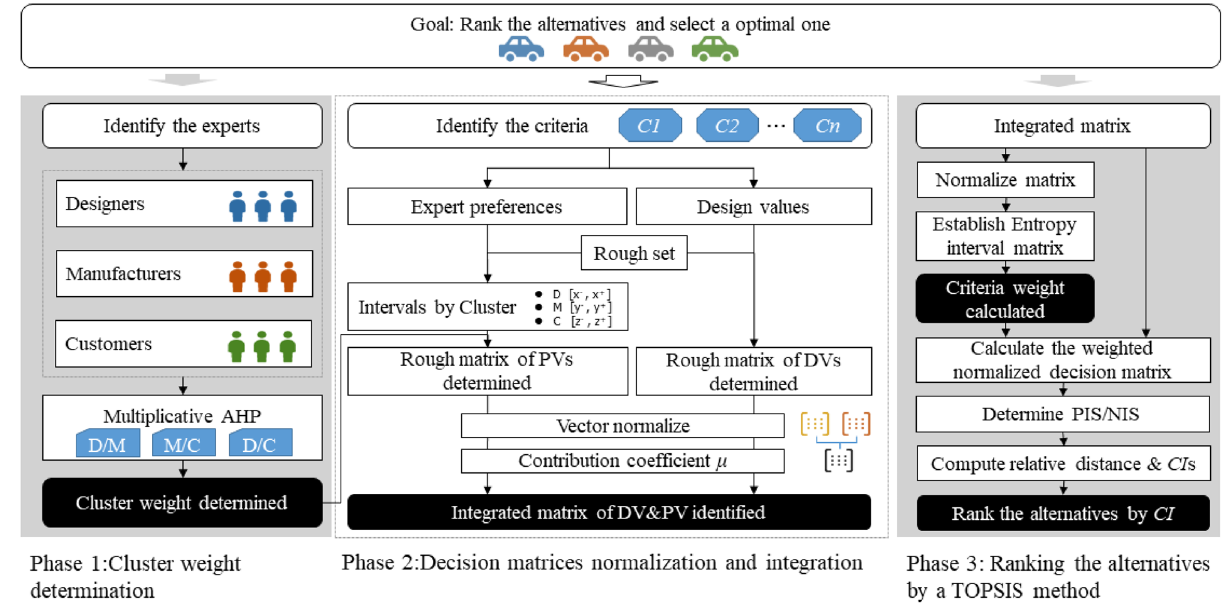
Figure 4. Framework of the proposed rough-TOPSIS method.